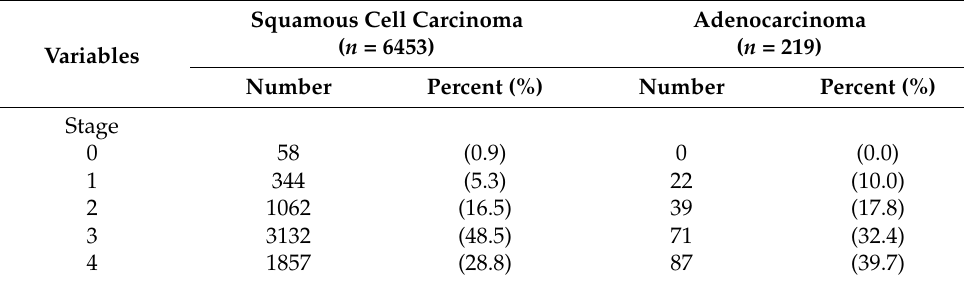
Table 3. Distribution of stage in patients with esophagus cancer ( n = 6672).